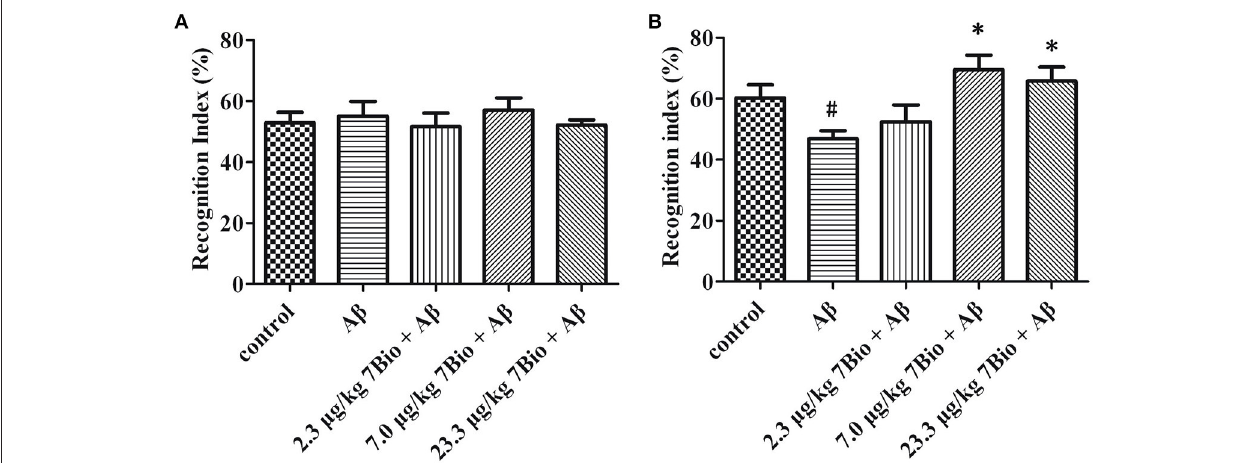
FIGURE 5 | 7Bio attenuates A β oligomer-induced cognitive impairments in mice . (A) In the 1st day of NOR, the recognition index was not significantly altered among various groups as indicated. (B) In the 2nd day of NOR, 7Bio significantly attenuated the reduction of recognition index induced by A β oligomer in mice. Data represent the mean ± SD ( n = 10); # p < 0.05 vs. control group, * p < 0.05 vs. A β group (one-way ANOVA and Tukey’s test).